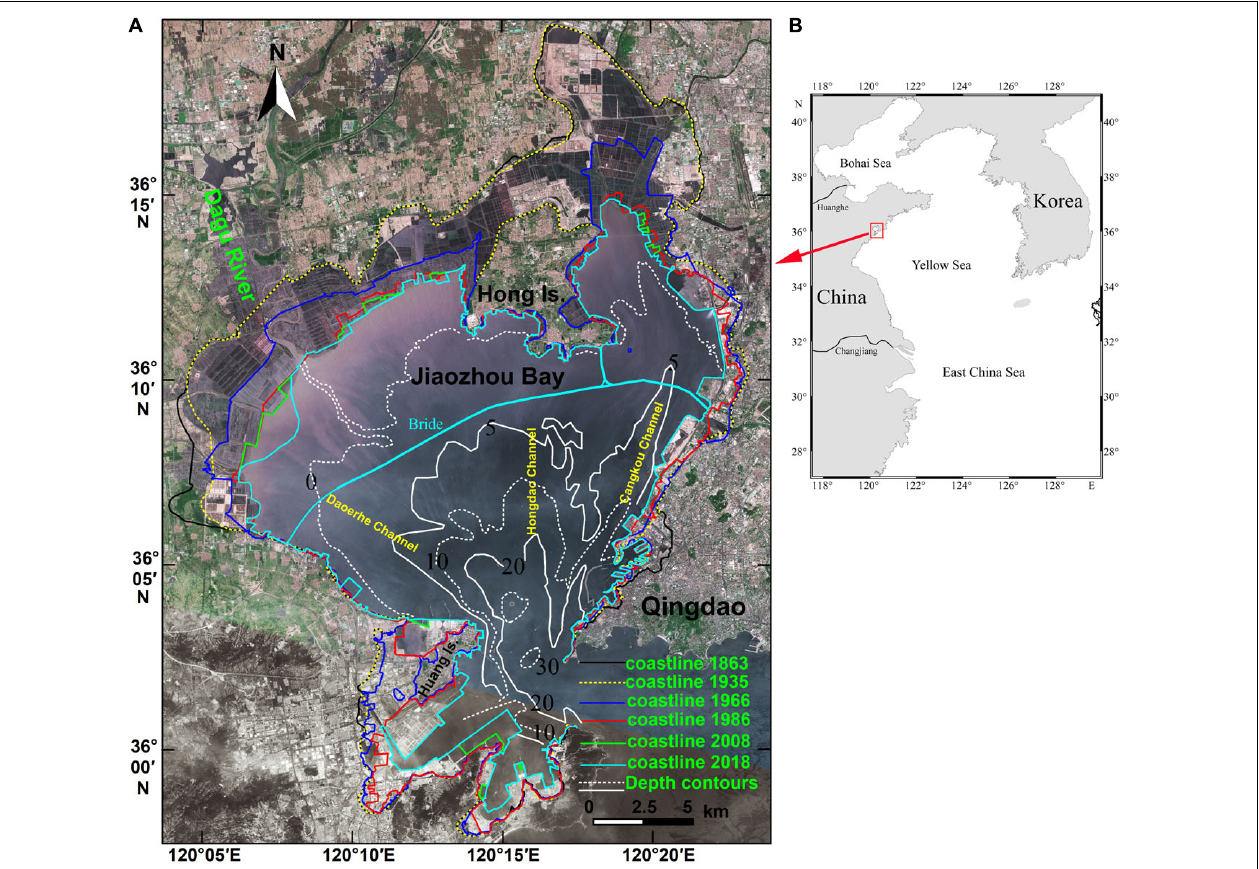
FIGURE 1 | Spatio-temporal coastline change and bathymetric contours of Jiaozhou Bay (A) , and location of Jiaozhou Bay (B) ; the background is from remote sensing imaging from 2008 and the bathymetric contours are derived from chart of 2005.